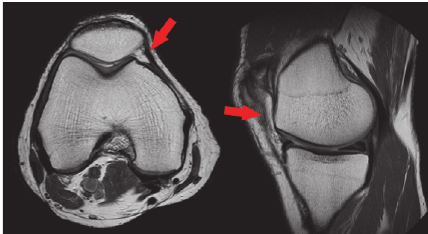
Figure 2: Prominent medial parapatellar plica indicated by arrow- heads.